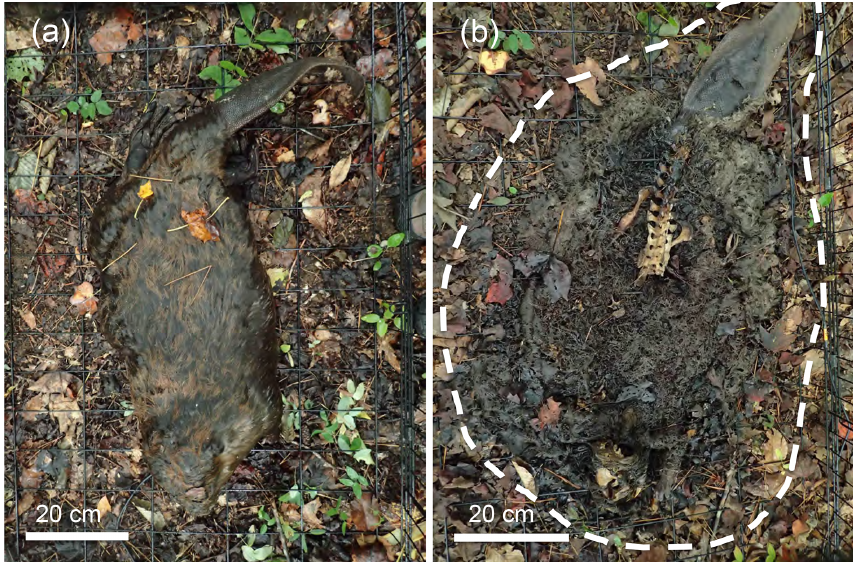
Figure 2. View of a beaver after placement (a) and during advanced decay (b) to demonstrate the lateral migration of carcass-derived fluids during decay. Both photos are from the same animal, and (b) were taken during advanced decay (8 August 2016). Visible extent of fluid migration is outlined in the white dashed